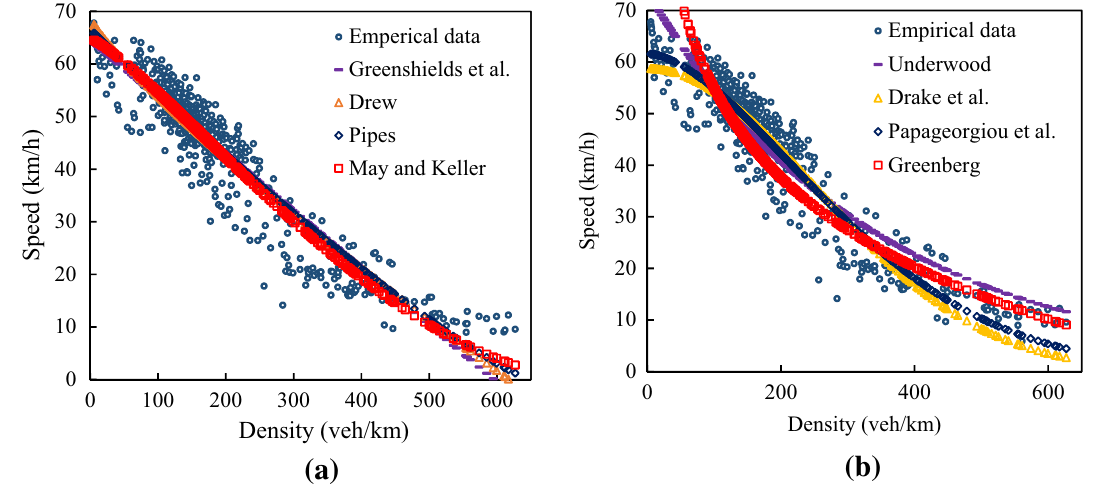
Fig. 5 Geometric fitness of the simple a linear and b exponential traffic stream models